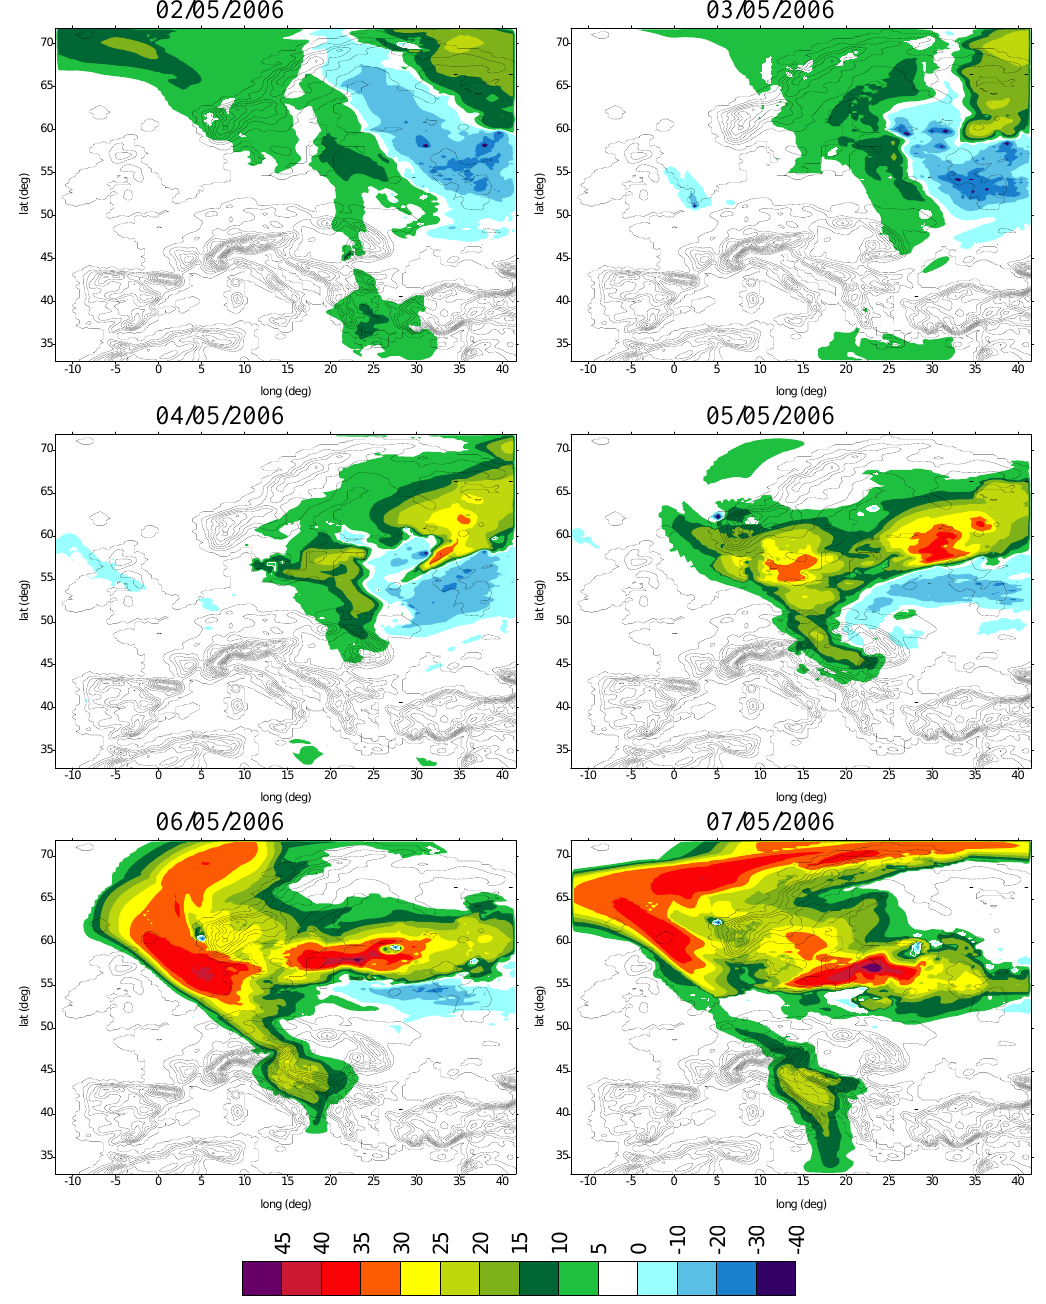
Fig. 9. Pure contribution of biomass burning emissions to maximum hourly surface O 3 (ppb) during the period 2–7 May 2006.